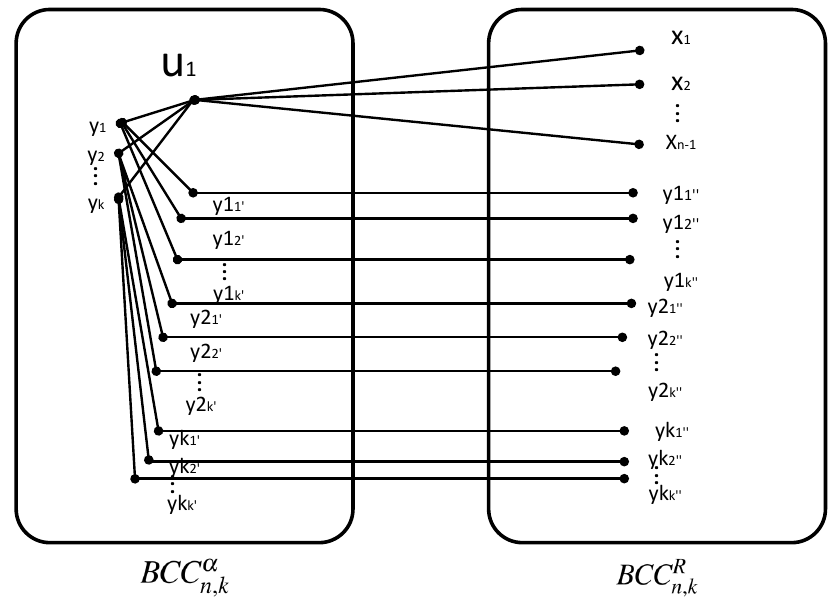
Figure 3. ( n − 1 )( k + 1 ) paths from u 1 to BCC R Subcase 1.1.2. u is u 2